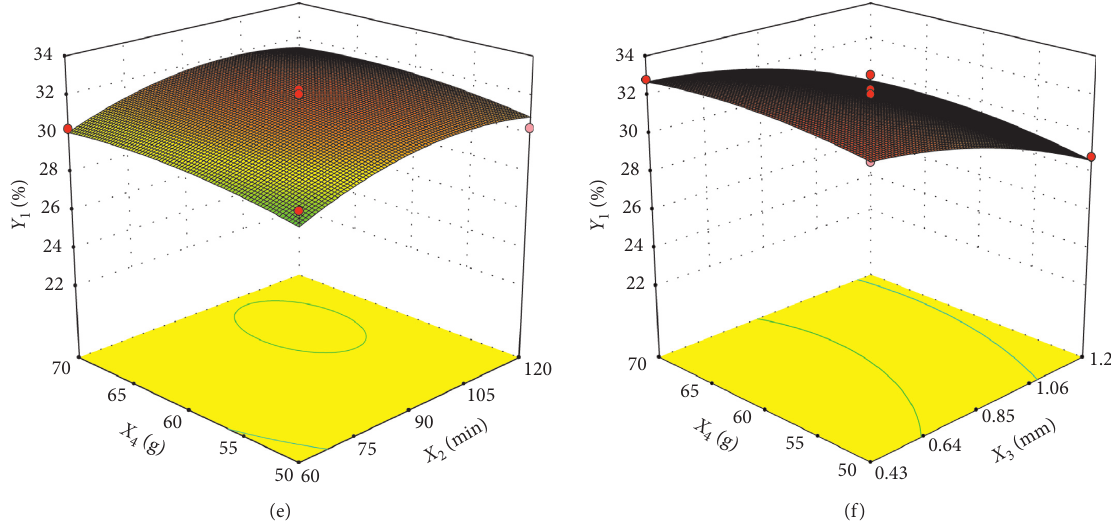
� 0.85mm, X � 60g. (b) X � 90min, 3 4 2